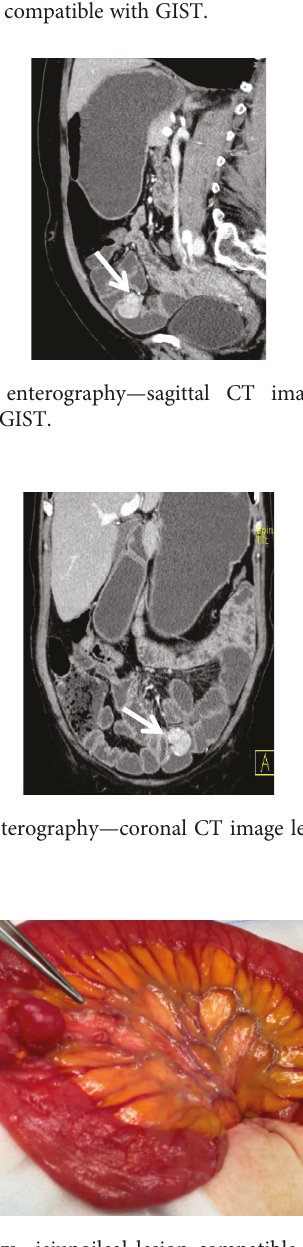
Figure 7: Surgery — jejunoileal lesion compatible with GIST with the endophytic and exophytic